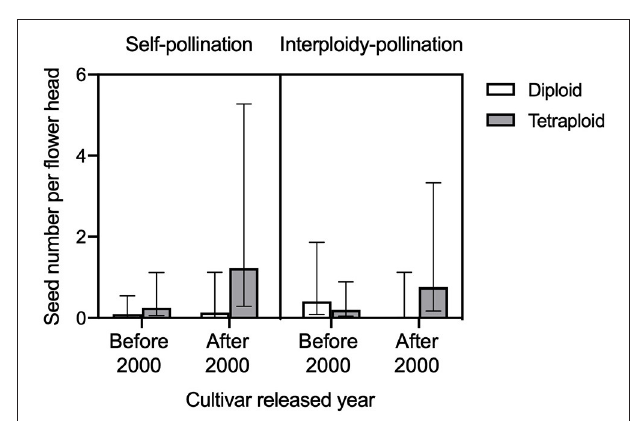
FIGURE 5 | Comparison of seed number per flower head in diploid and tetraploid with different released year (before 2000 and after 2000) under self-pollination (left) and interploidy-pollination (right). Error bars indicate the 95% confidence interval of the estimated marginal means